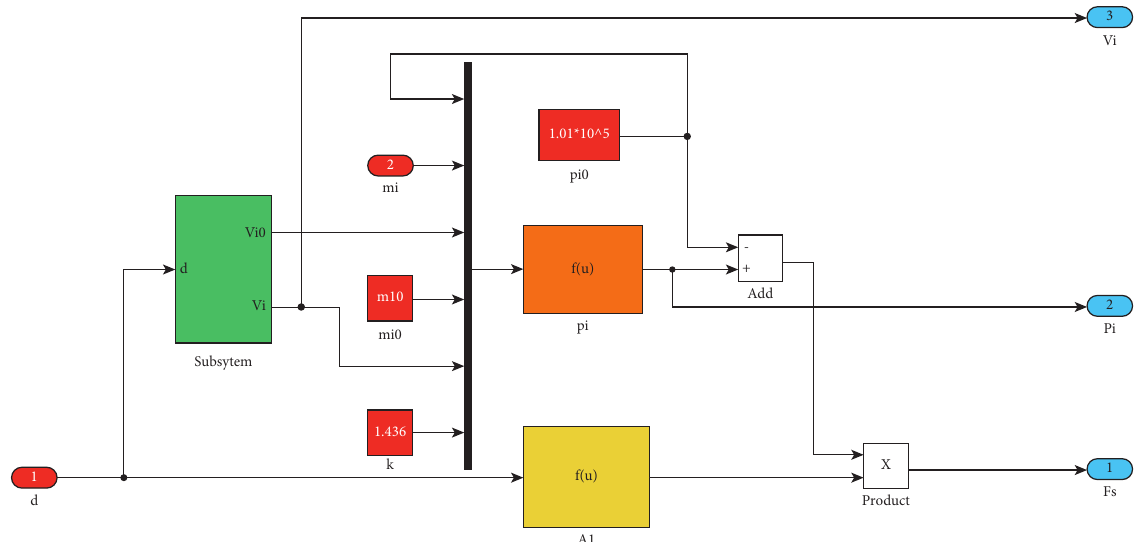
Figure 5: Simulink module of air